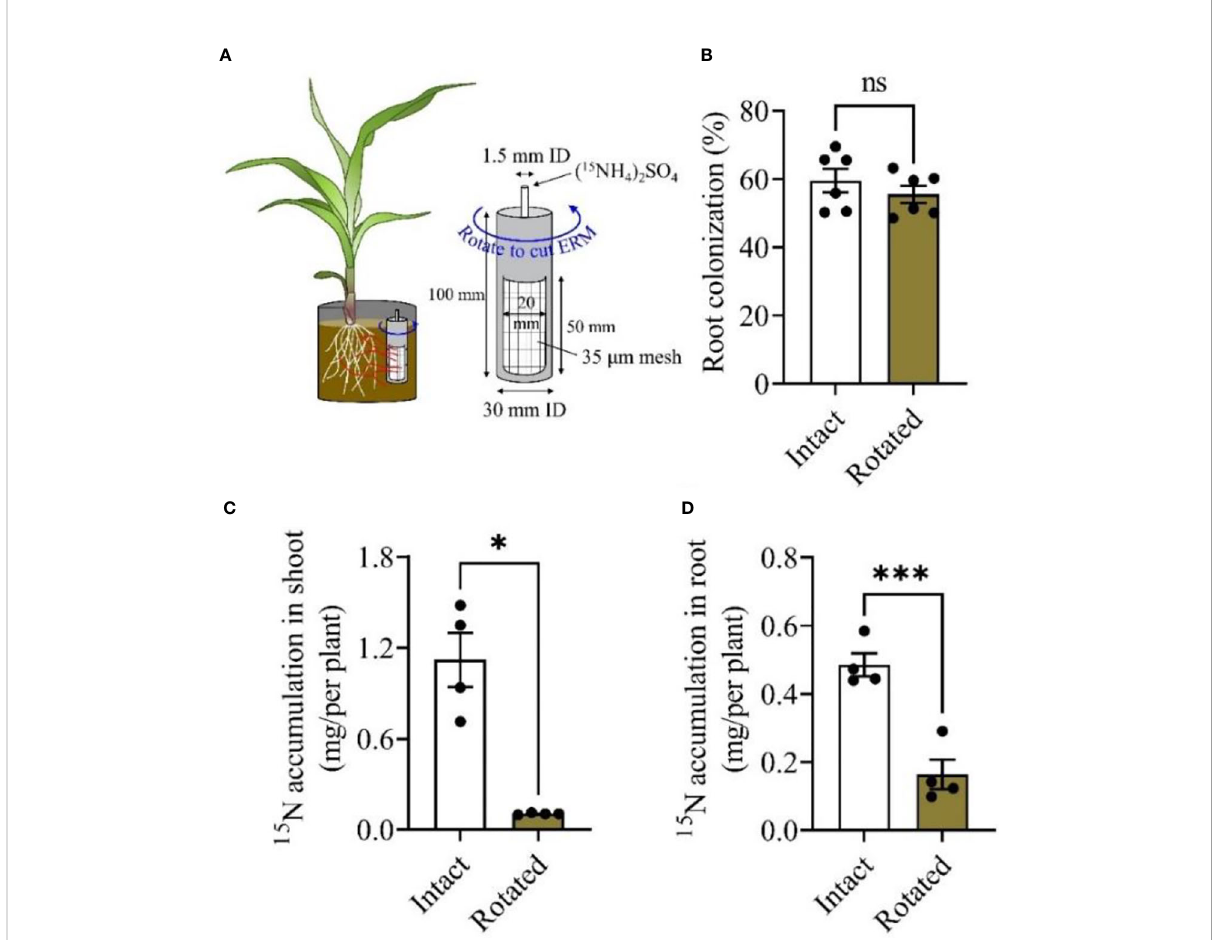
FIGURE 2 Mycorrhiza-mediated nitrogen uptake from soil by maize plants. Maize plants were inoculated with the mycorrhizal fungus Rhizophagus irregularis ( Rir ) and cultivated in the boxes with a PVC core in each box (A) . Five weeks post Rir inoculation, the PVC core was injected with ( 15 NH 4 ) 2 SO 4 solution, and was then either rotated daily (for the purpose of damaging the mycelium) or non-rotated (intact for maintaining mycelial contact to labeling 15 N). Plants were harvested to measure the root colonization rate (B) and the accumulation of shoot 15 N (C) and root 15 N (D) ten days after labeling N injection. For the analysis of root colonization, n = 6; 15 N accumulation, n = 4. Data are the means ± SE of biological replicates. Asterisks indicate signi fi cant differences (Student ’ s t-test, * P < 0.05; *** P < 0.001; ns, no signi fi